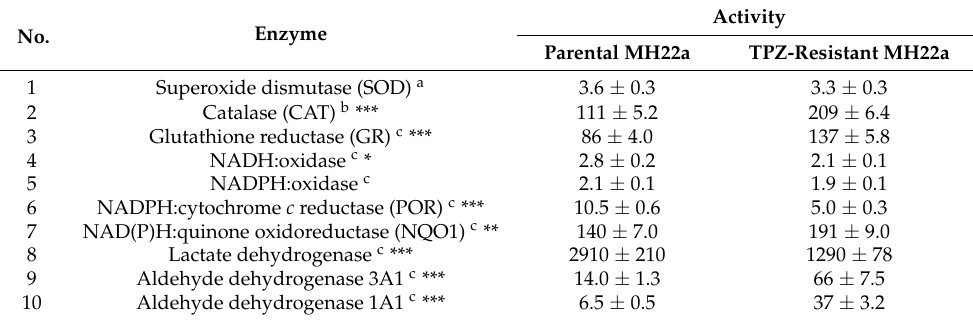
Table 4. The activities of redox enzymes in MH22a cells and their TPZ-resistant